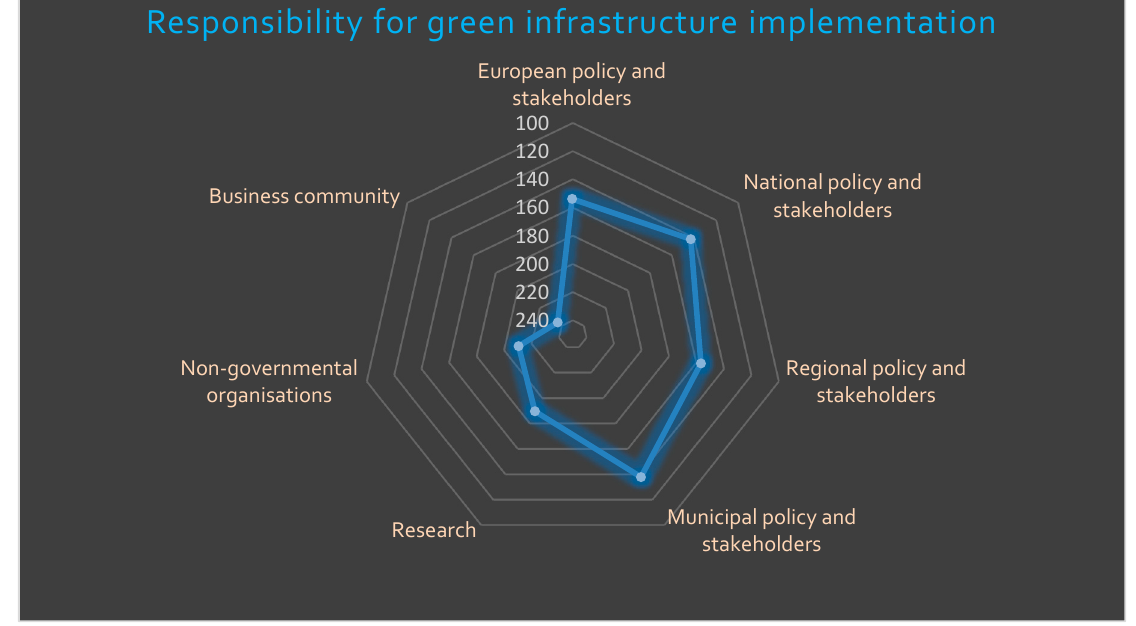
Figure 2. Groups of actors responsible for developing a policy for green infrastructure in the 32 European countries (EU28 and Iceland, Liechtenstein, Norway and Switzerland) based on a summary of 41 online survey responses. The actors/institutions with the lowest score were considered to have the greatest responsibility.